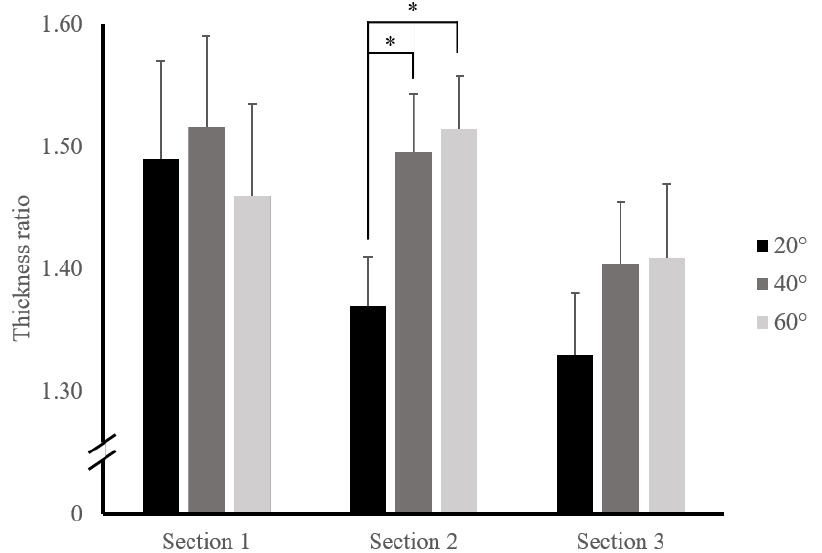
Figure 4. Group mean ratio of thickness changes by each curl-up angle in each section (the error bars indicate the standard error). Note that all curl-up angles showed significant differences in each section when compared to the rest position. * p < 0.05.